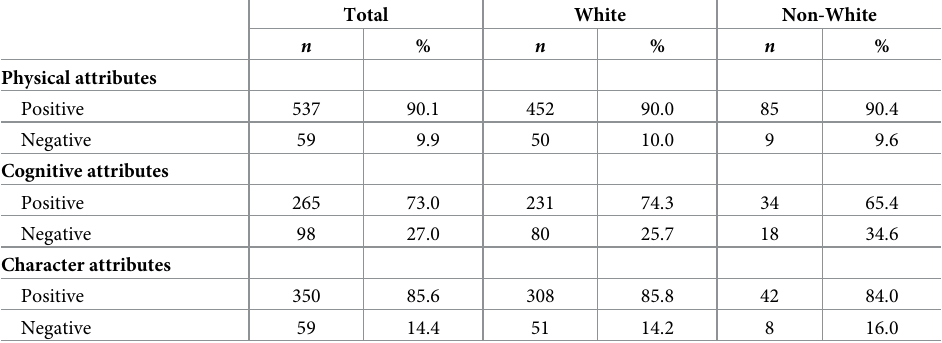
Table 4. Proportion of positive and negative statements by race within each main attribute